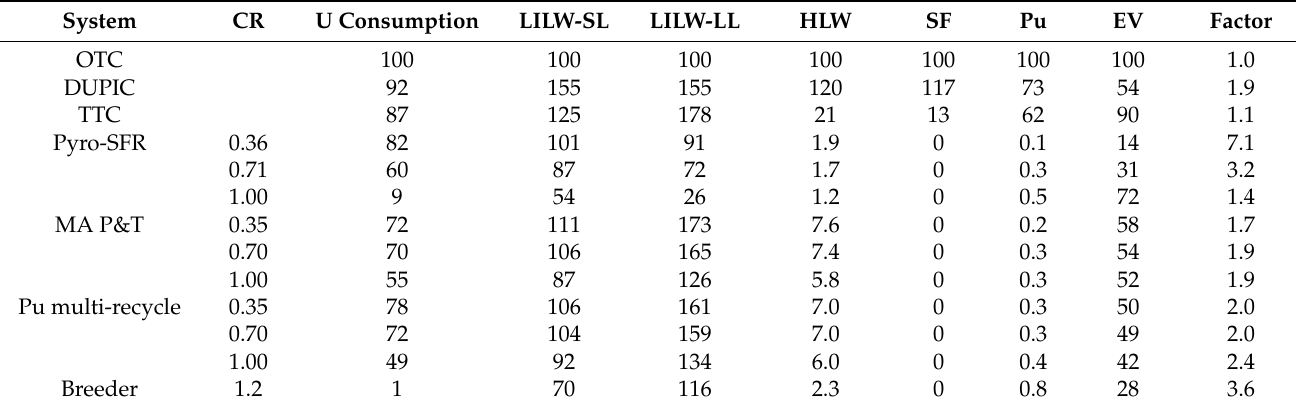
Table 5. Results from fuel cycle studies of Gao and Ko [52].